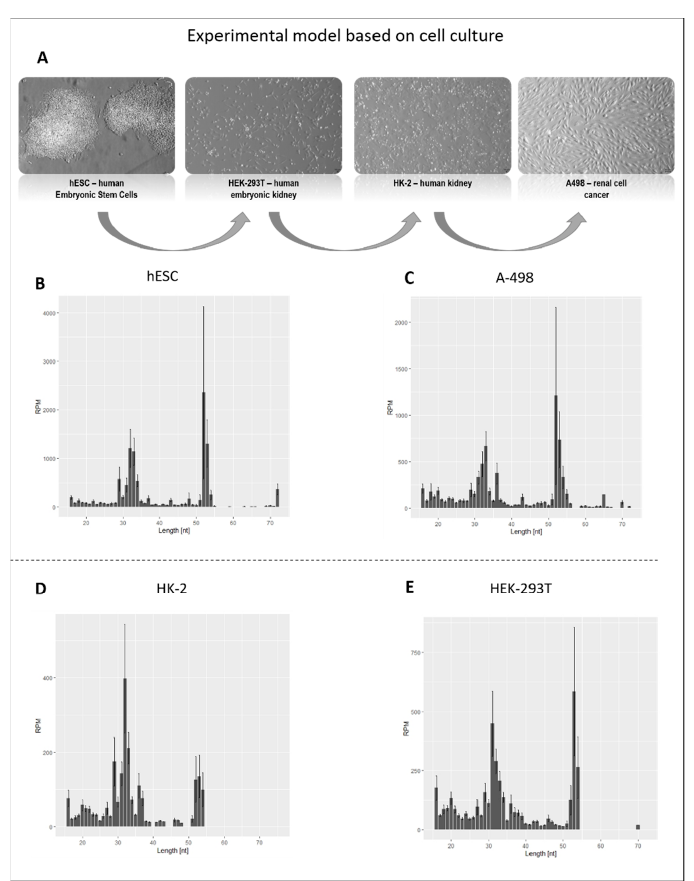
Figure 1. The size distribution (in nucleotide length) of tRNA-derived fragments isolated from renal cells. ( A ) The physiology of model cell cultures. ( B – E ) The names of the analyzed cells are shown at the top of each panel. RPM—reads per million.